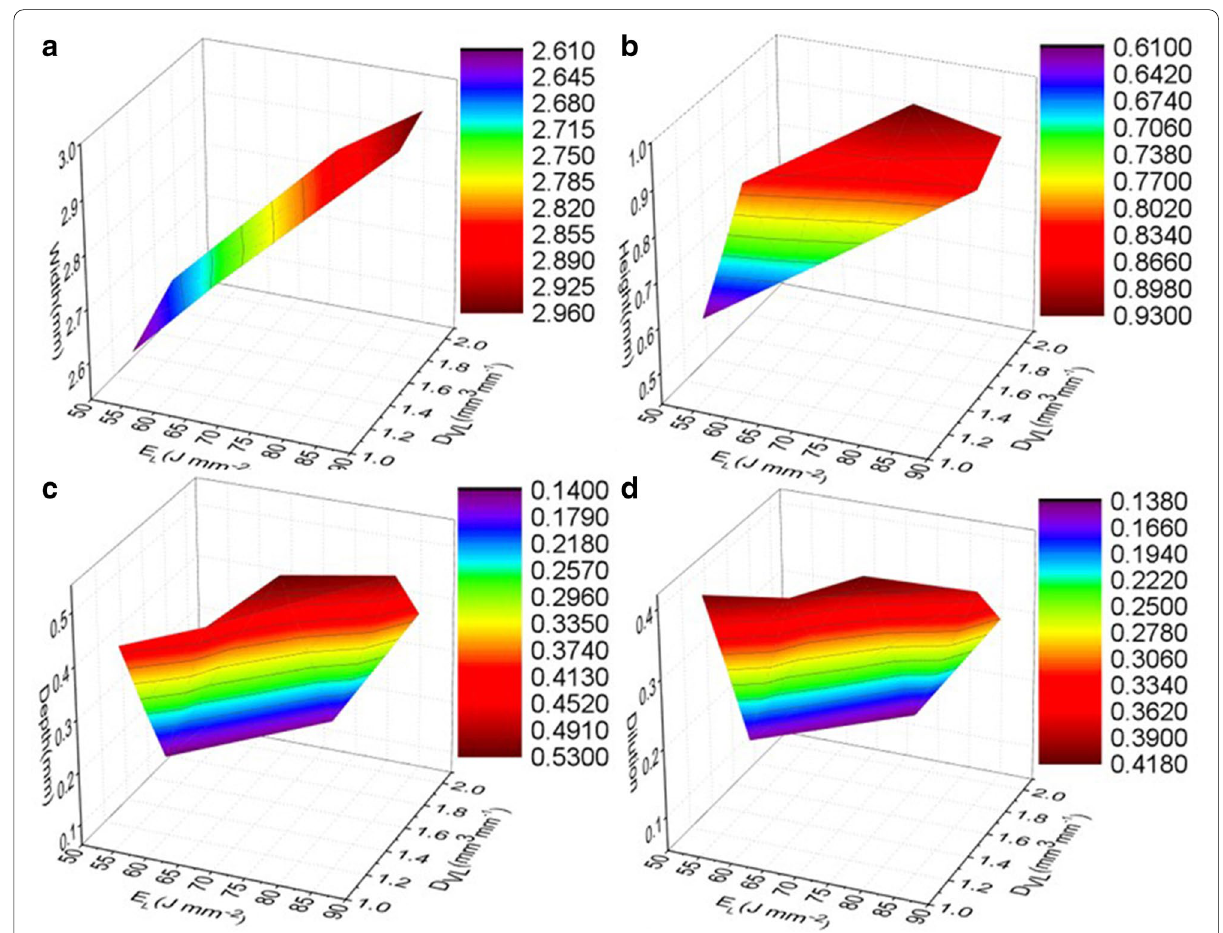
Figure 28 Influence of process parameters on geometrical characteristics of cladding layer at H dilution